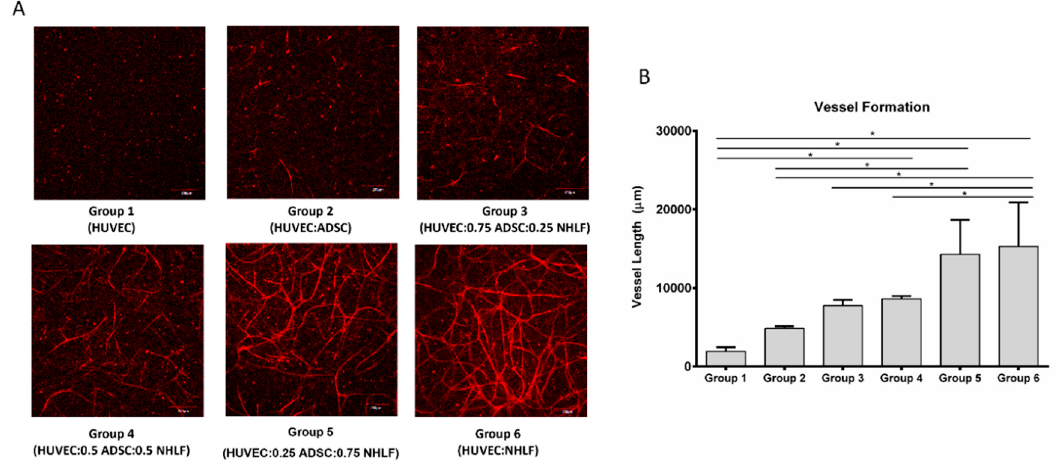
Figure 4. Vessel-like structures in 3D culture. ( A ) CD31 staining of samples from different cell ratio combinations. ( B ) Quantification of total vessel length from different cell ratio combinations. For all datasets, values are mean ± SD, n = 4. One-way ANOVA followed by Tukey’s multiple comparisons test was performed. *Denotes significant difference ( p < 0.05) between groups.